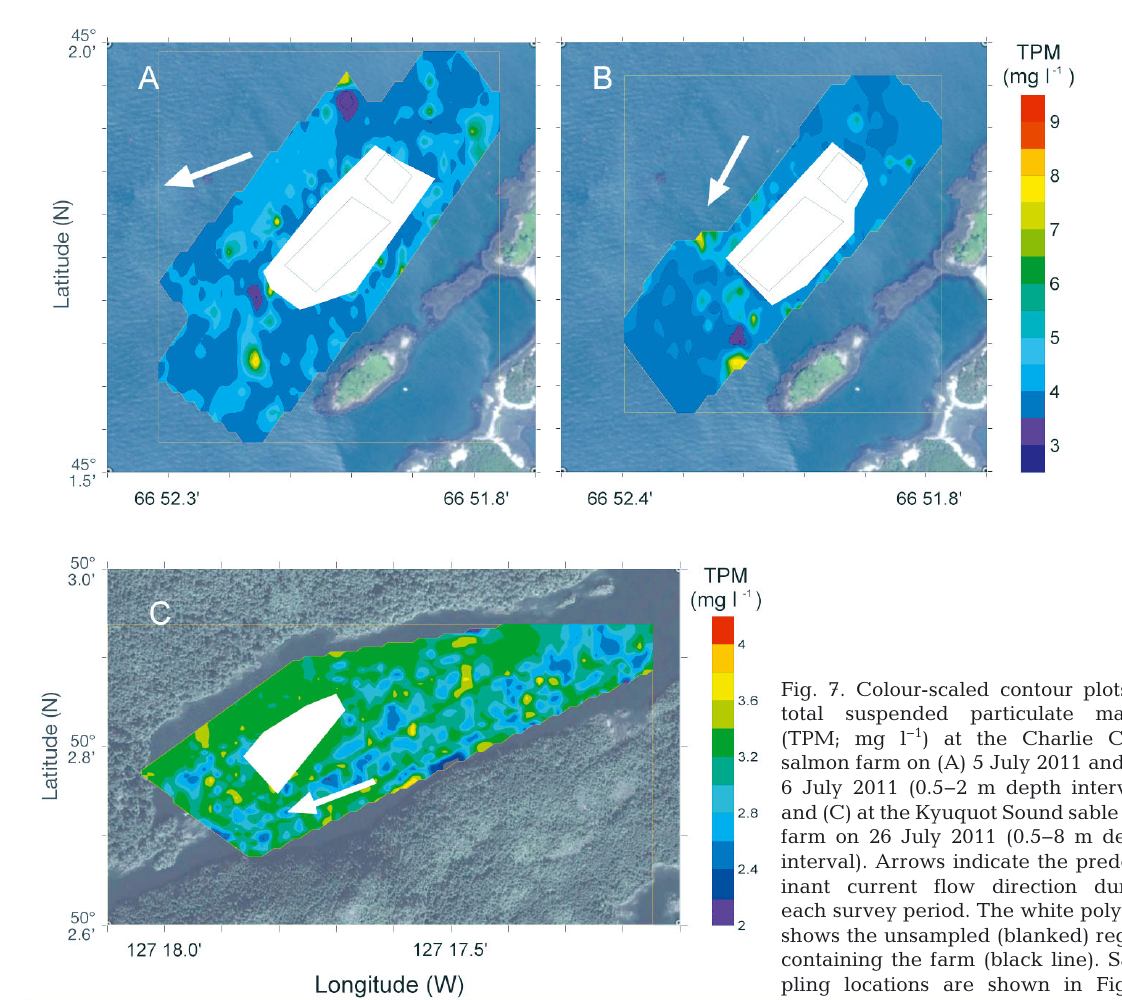
Fig. 7. Colour-scaled contour plots of total suspended particulate matter (TPM; mg l −1 ) at the Charlie Cove salmon farm on (A) 5 July 2011 and (B) 6 July 2011 (0.5−2 m depth interval), and (C) at the Kyuquot Sound sable fish farm on 26 July 2011 (0.5−8 m depth interval). Arrows indicate the predom - inant current flow direction during each survey period. The white polygon shows the unsampled (blanked) region containing the farm (black line). Sam- pling locations are shown in Fig.